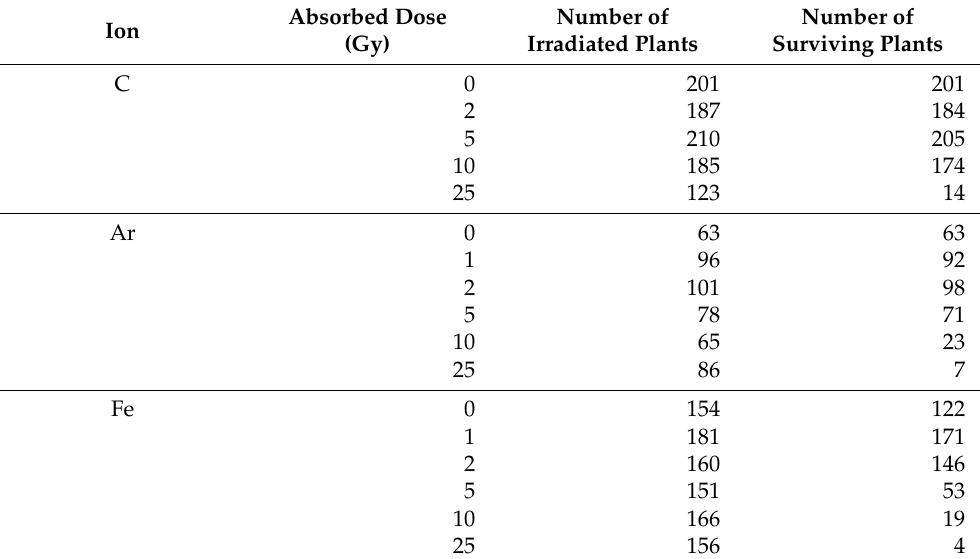
Table 4. Number of gerbera in vitro shoots irradiated with ion